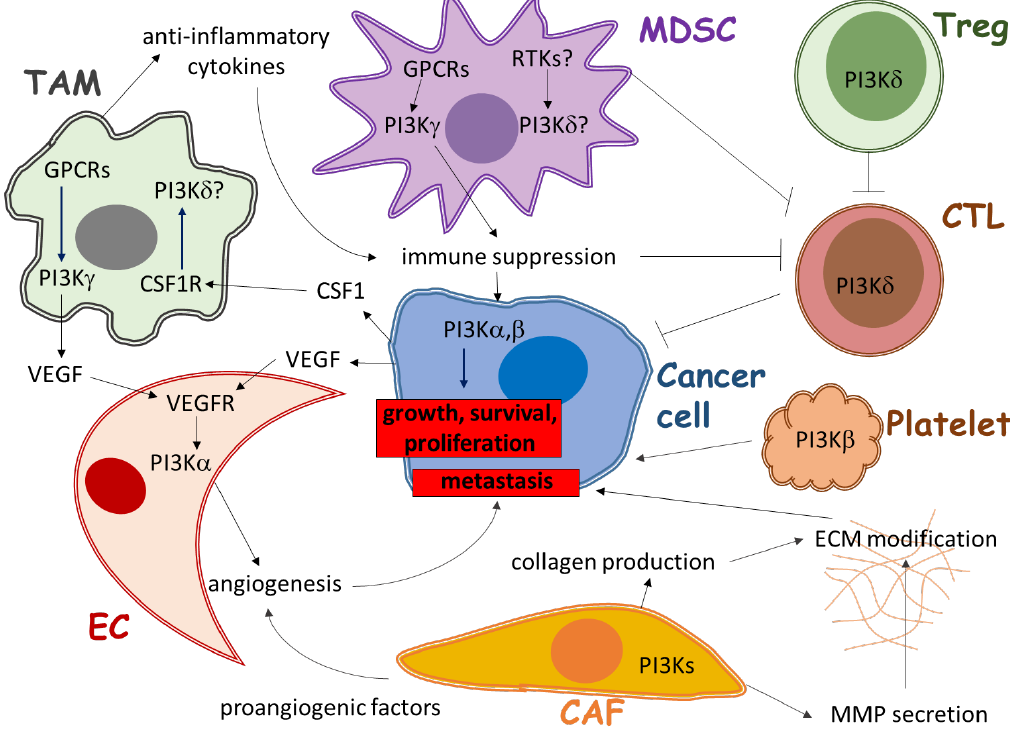
Figure 1. Cellular composition of the tumor microenvironment and the role of Class (I) phosphoinositide 3-kinase (PI3K) isoforms in the stromal cells which support cancer growth and progression. TAM: tumor-associated macrophage, MDSC: myeloid-derived suppressor cell, Treg: regulatory T lymphocyte, CAF: cancer-associated fibroblast, EC: endothelial cell, CTL: cytotoxic T lymphocyte, GPCR: G protein-coupled receptor, RTK: receptor tyrosine kinase.